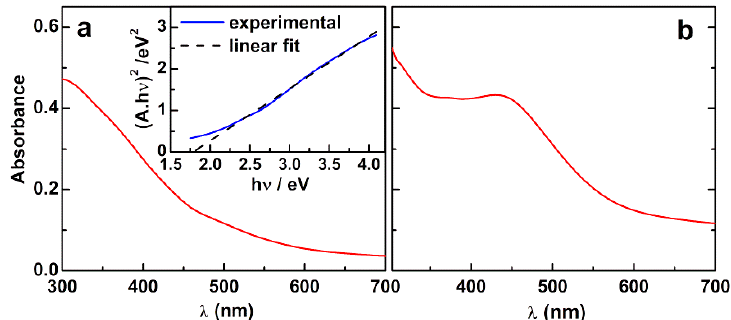
Figure 1. UV-Visible absorption spectra of aqueous dispersions of ( a ) zinc / calcium ferrite nanoparticles and ( b ) silver-decorated nanoparticles.